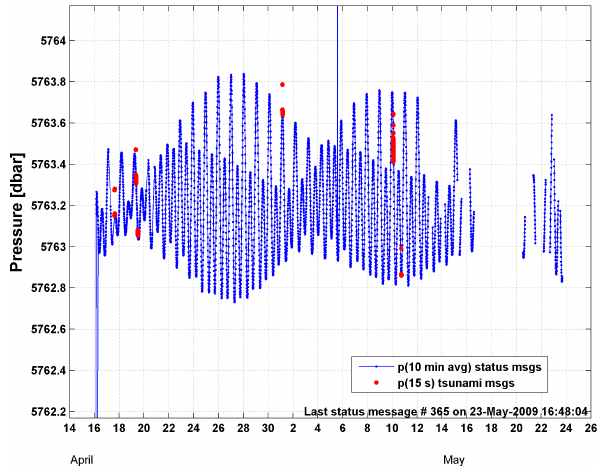
Fig. 15. Summary of approximately 37 days of real time data from position Sumatra-3. Blue dots represent 10-min pressure averages (transmitted via status messages), red dots 15-s instant data (trans- mitted as part of tsunami messages when system was in capturing tsunami mode ).